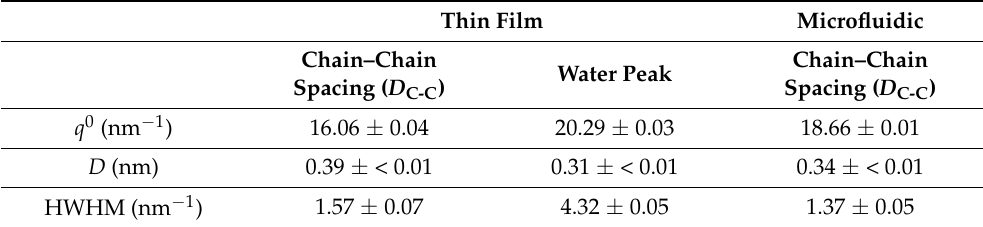
Table 2. Fitting parameter of main scattering peaks in wide-angle. Chain–chain ( D C-C ) are expressed in nm − 1 in reciprocal space and in nm in real space.